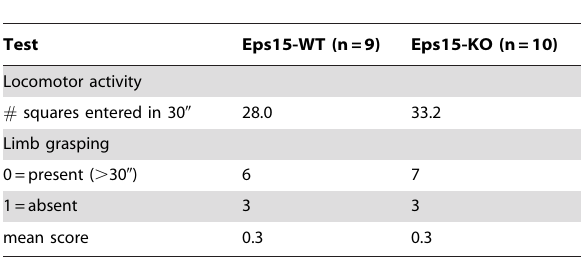
Table 8. Normal motor activity in aged Eps15-KO